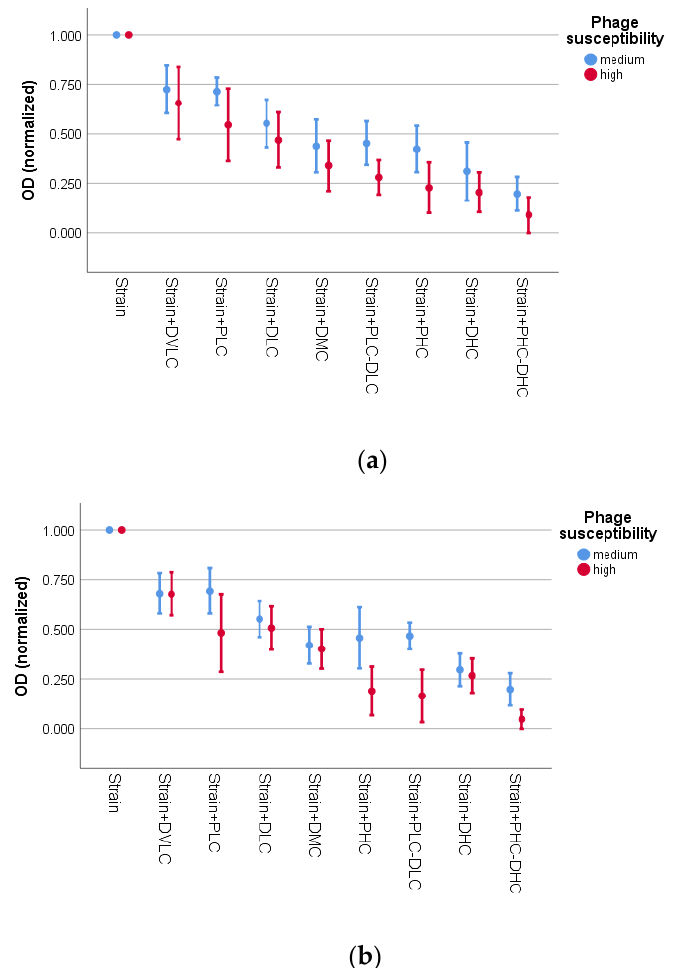
Figure 1. Effect of interventions on normalized OD of strains in relation to susceptibility to phage for ( a ) CV assay and ( b ) MTT assay. Error bars indicate mean OD ± 2 standard error. PLC: 10 4 pfu/mL (phage low concentration); PHC: 10 6 pfu/mL (phage high concentration); DVLC: 0.1 mg/L (dap-